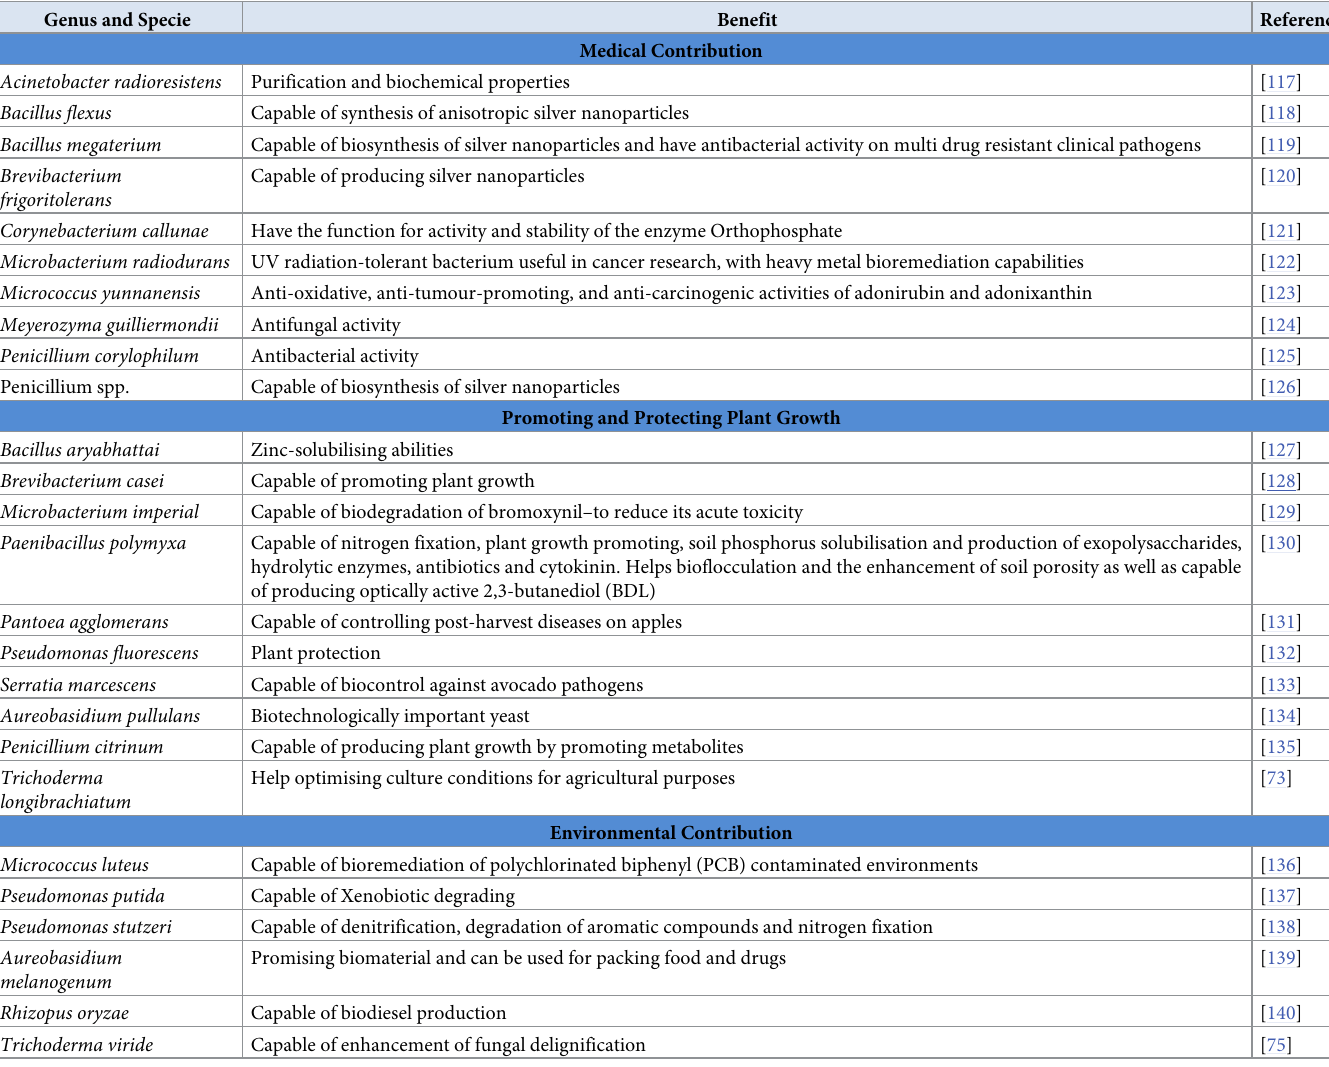
Table 3. Alphabetical classification of useful bioaerosols detected (peak and off-peak seasons) according to: medical contribution, promoting and protecting plant growth and environmental contribution. Genus and